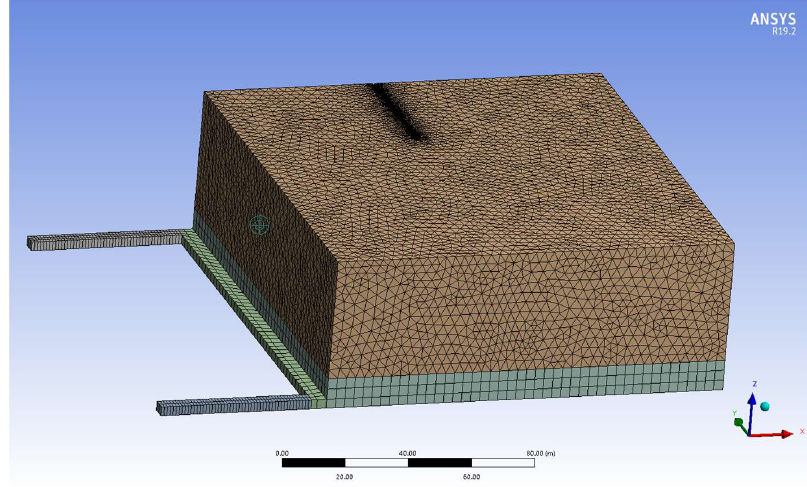
Figure 6. Physical model of the extraction area. The height of the bubble fall zone is shown in Equation (15).